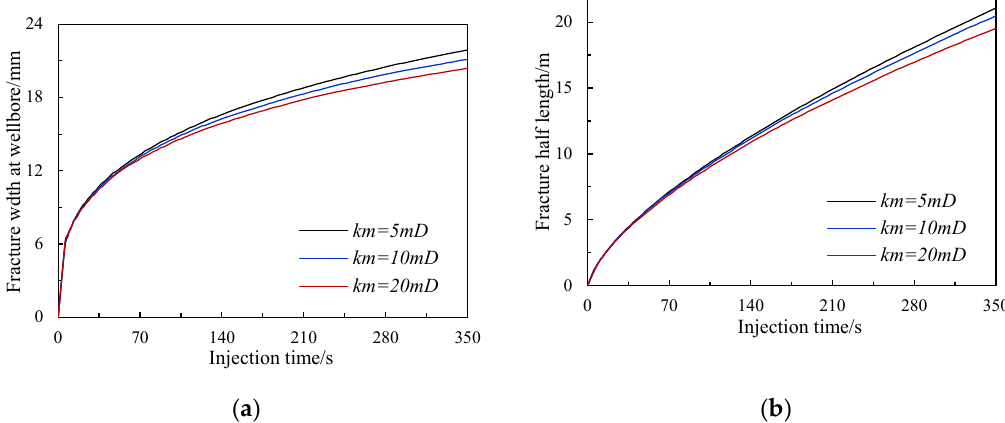
m = 5 mD; ( b ) k m = 10 mD; and ( c ) k m = 20 mD.